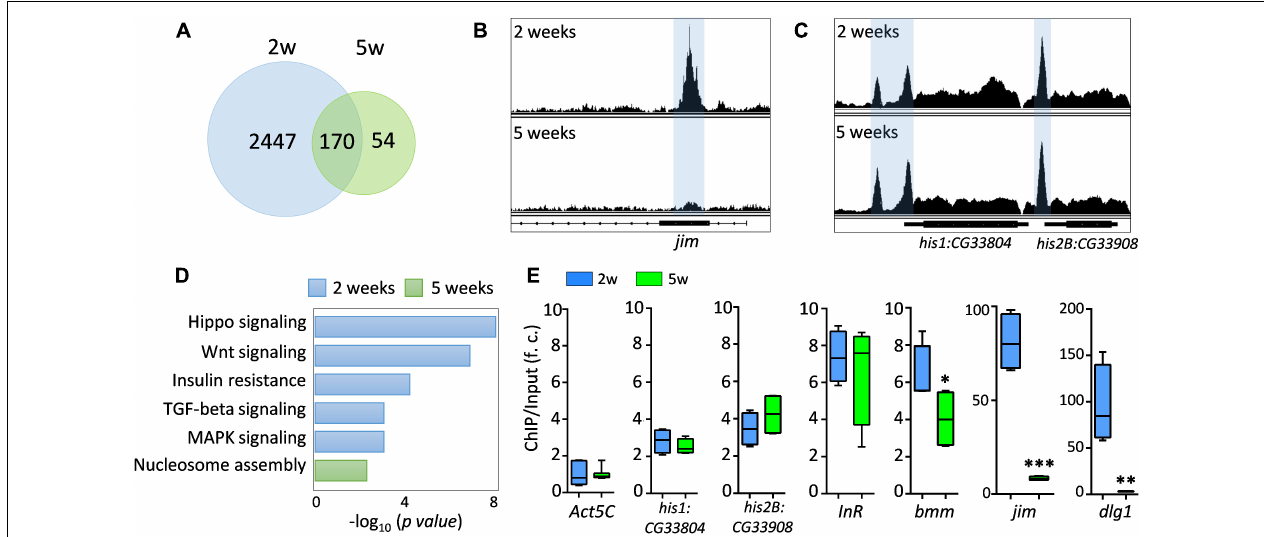
FIGURE 2 | FOXO binding activity decreases with age. (A) The number of genes targeted by FOXO at young (2 weeks) and aged flies (5 weeks). (B) Age-dependent FOXO binding at jim locus. (C) Age-dependent FOXO binding at his1:CG33804 and his2B:CG33908 loci. (D) GO terms for FOXO-targeted pathways uniquely enriched in young or aged flies. (E) qPCR validation of the FOXO binding enrichment at the selected FOXO targeted genomic loci. FOXO binding at Act5C locus serves as an internal control. The enrichment value is calculated as the fold-change (f. c.) of the FOXO binding (ChIP vs. Input) between FOXO-targeted loci and Act5C locus. Student t -test ( ∗∗∗ p < 0.001; ∗∗ p < 0.01; ∗ p < 0.05).